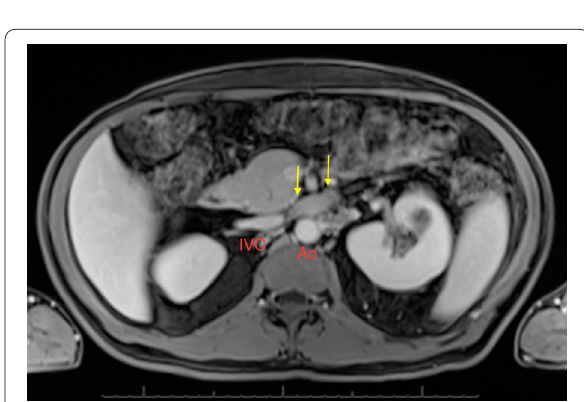
Fig. 3 Axial MRI image showing fullness of left renal vein (yellow arrow) suggestive of renal vein thrombus